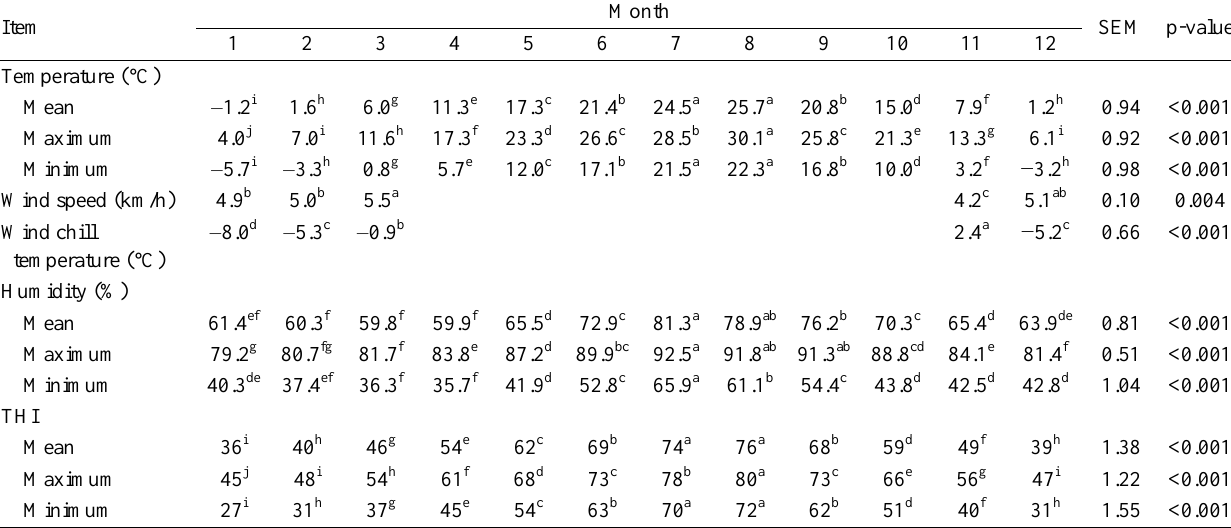
Table 1. Monthly temperature, relative humidity, and temperature-humidity index (THI) values for 8 years (2006 through 2013) in South